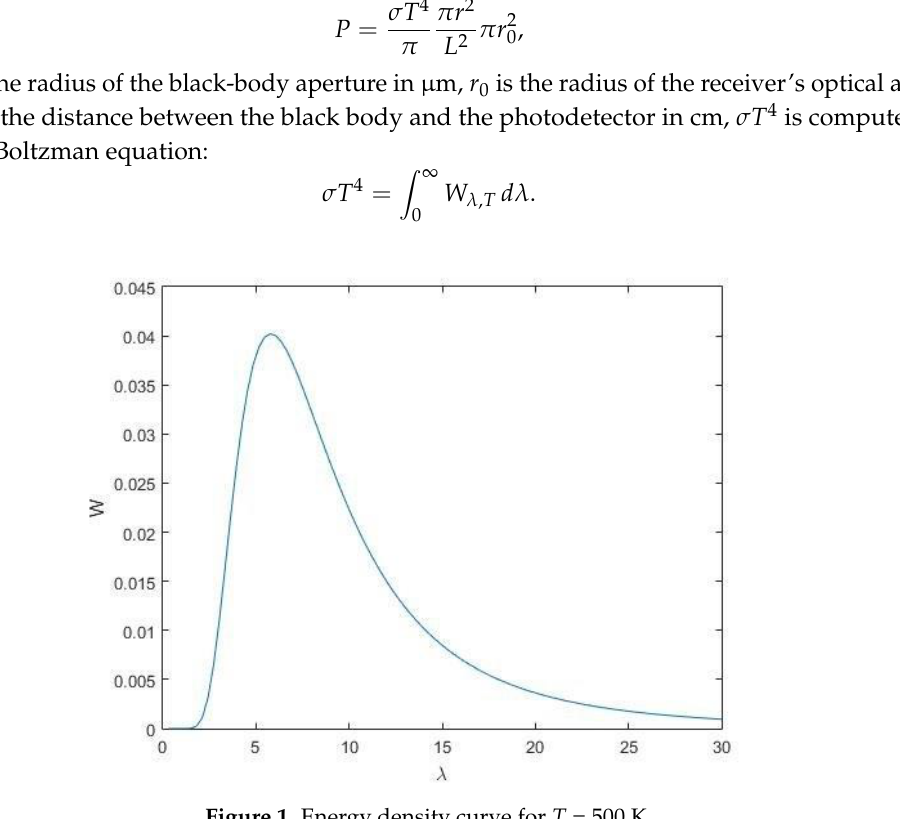
Figure 1. Energy density curve for T = 500